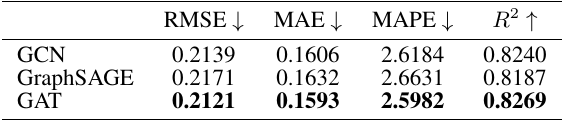
Table 3. Results of using different GNN